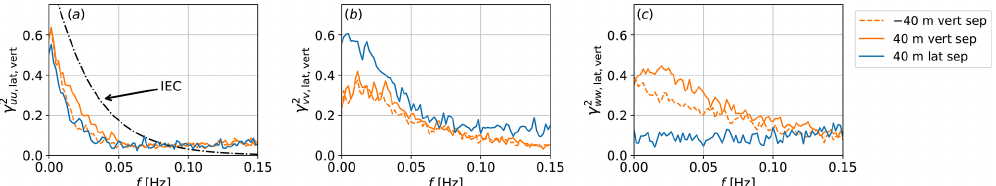
Figure 12. Comparison of lateral and vertical coherences related to separations of 40m. Negative separation means one point is below the reference point located at 80m, while positive separation means the second point is above the reference